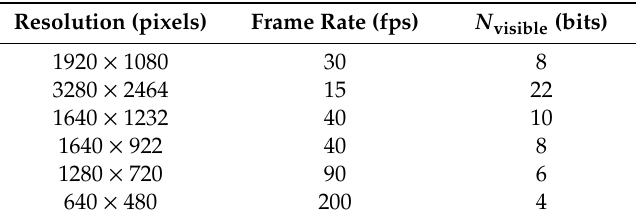
Table 1. RaspiCam resolutions.